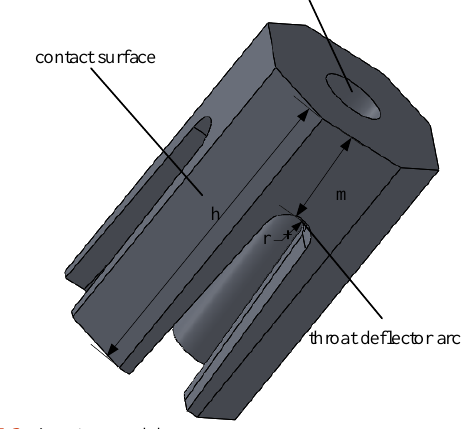
FIGURE 2. Armature model